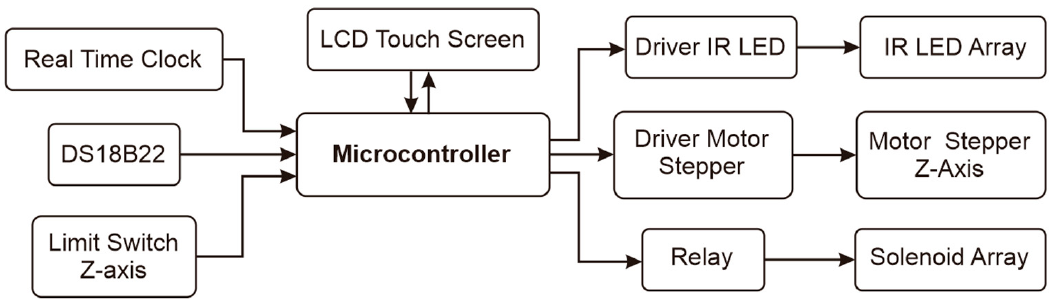
Figure 4. Block diagram system .